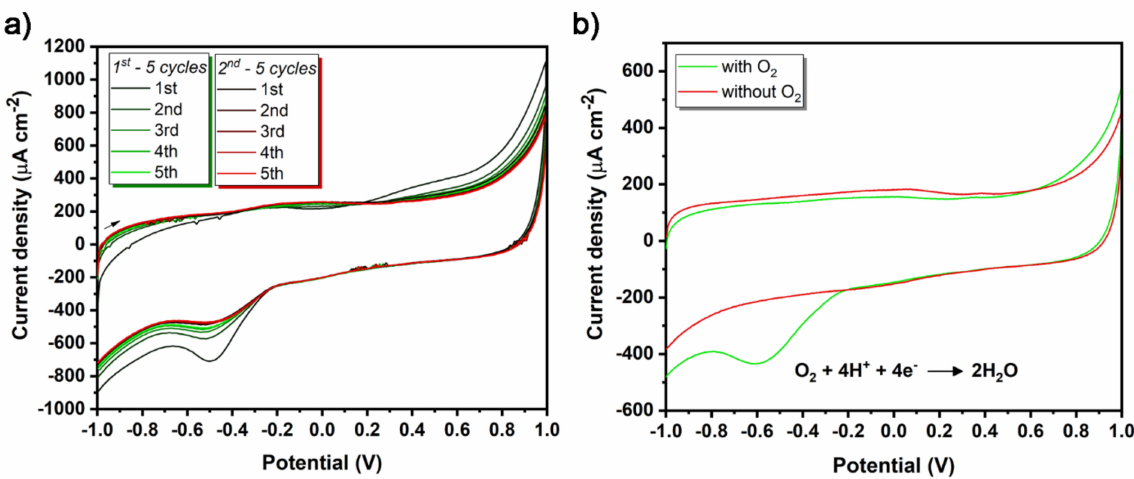
Figure 3. Cyclic voltammograms, from − 1.0 to 1.0 V at 100 mV s − 1 , of LIG electrodes. ( a ) Running 10 cycles (2 × 5cycles) to stabilize the electrode before being used. ( b ) CVs after stabilization in the presence and absence of O 2 . PBS (pH 7.4, 10 mM) was used as electrolyte and the potentials were measured against Ag/AgCl (1 M